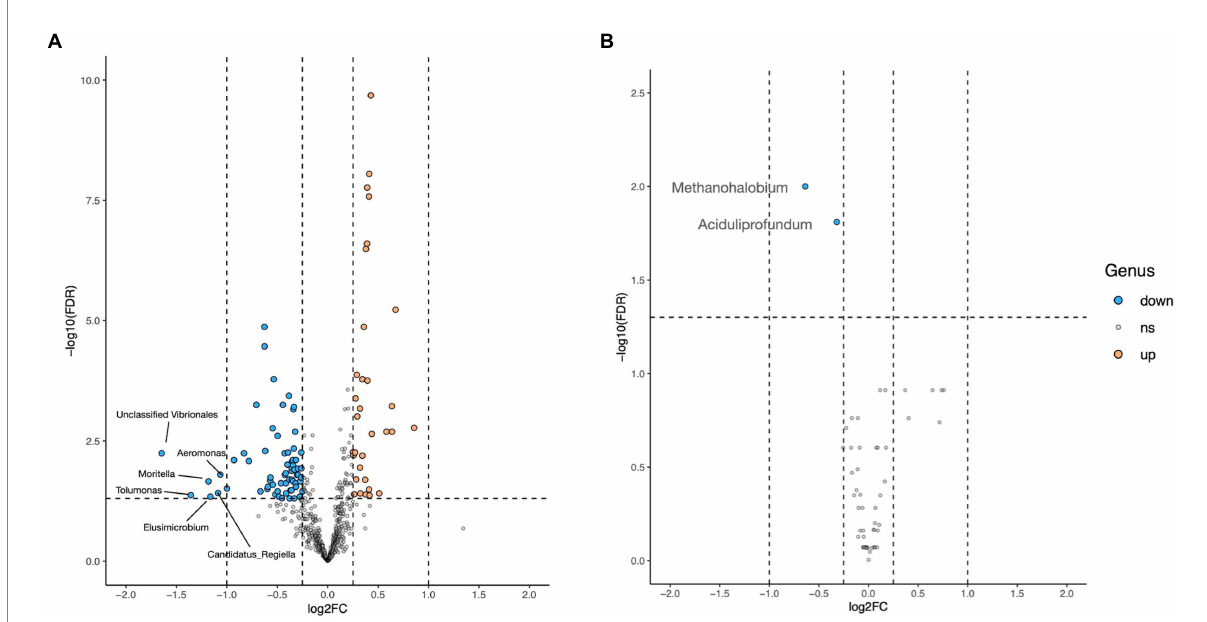
FIGURE 4 Volcano plot showing the difference in bacterial (A) and archaeal (B) abundance at the genus level between the CON and HD treatment groups. The blue dot indicates downregulation, the orange dot indicates upregulation, while gray dots depict no change. The log2 fold change is represented on the x-axis represents, while the y-axis represents the-log10 of FDR-corrected p